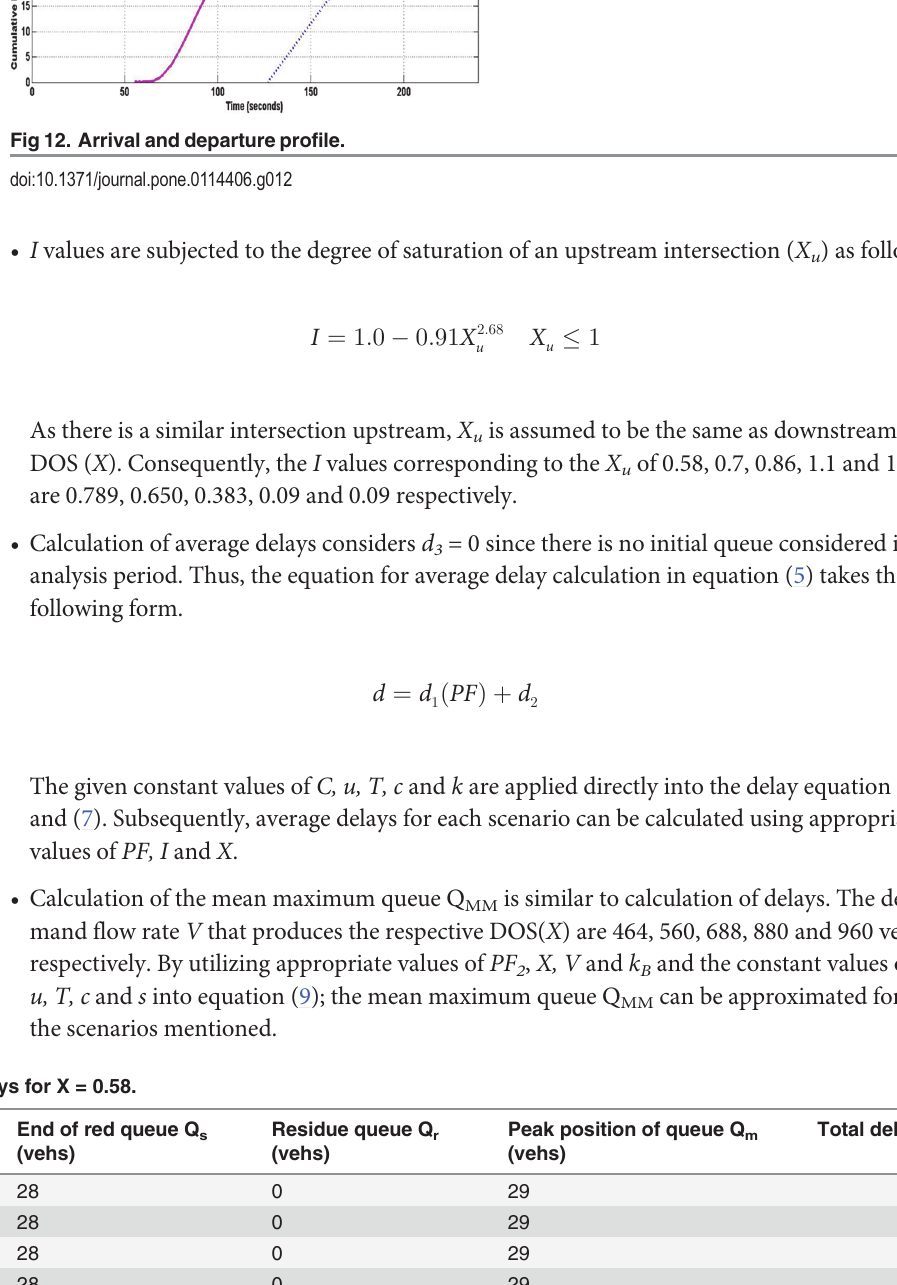
Peak position of queue Q m (vehs)